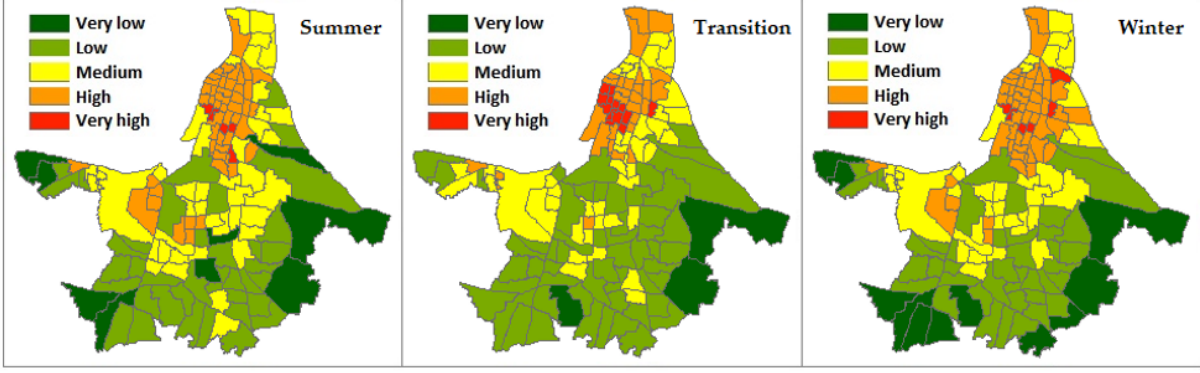
Figure 6. Ward-wise spatial variability of classified LST in the different seasons.